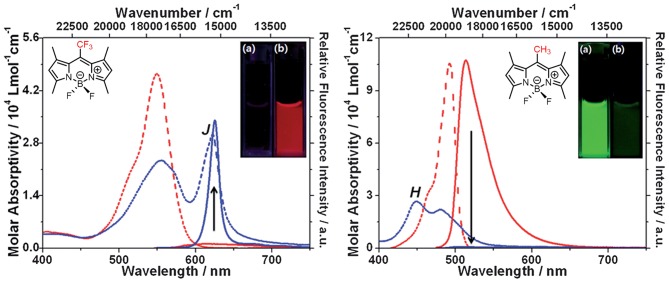
Different aggregation behavior of 17a (2 × 10−5 mol L−1) and it's analog with a methyl group at the meso-position in acetonitrile and acetonitrile-water mixtures (1:99, v: v). Dotted and solid lines refer to the absorption and emission spectra of BODIPYs, respectively (adapted with permission from Choi et al., 2014, Copyright 2014, Royal Chemistry Society).